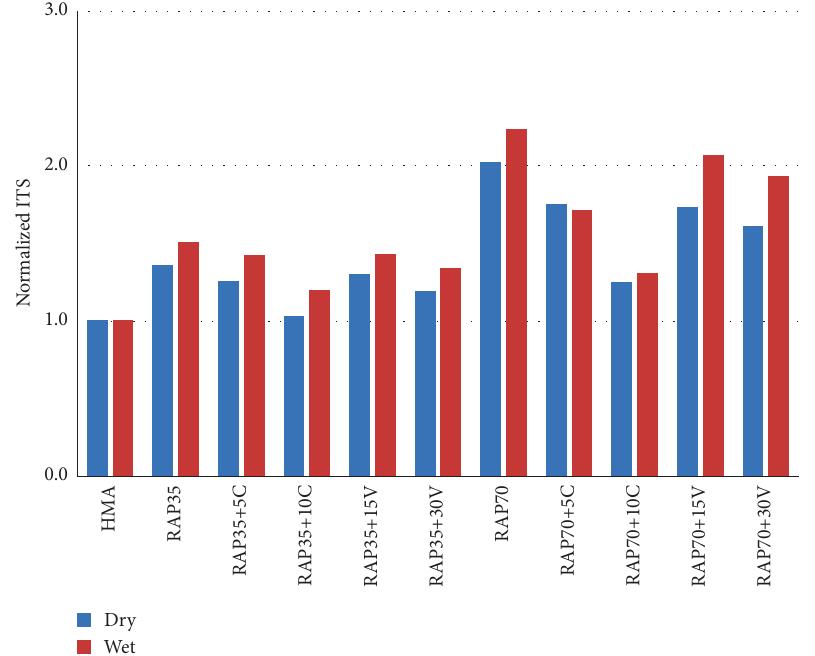
Figure 3: Efect of RAP and rejuvenating agents on the normalized ITS of asphalt mixtures.